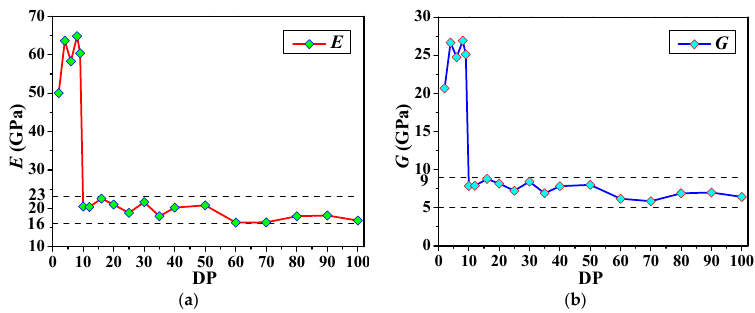
Figure 2. Changes of ( a ) the tensile modulus ( E ) and ( b ) the shear modulus ( G ) with DP simulated using the COMPASS force field.